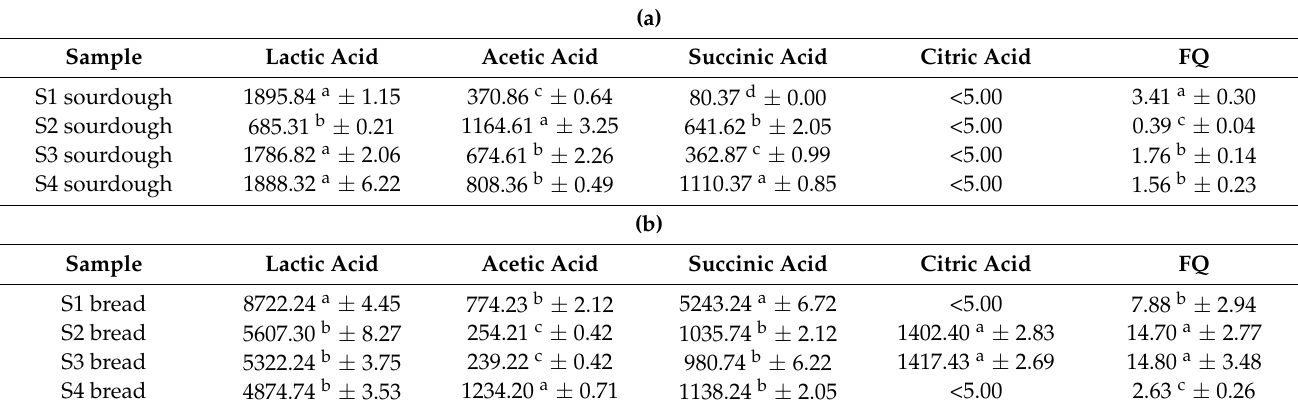
Table 4. Organic acid concentration (mg/kg) and fermentation quotient (FQ) in sourdough ( a ) and corresponding bread ( b ).